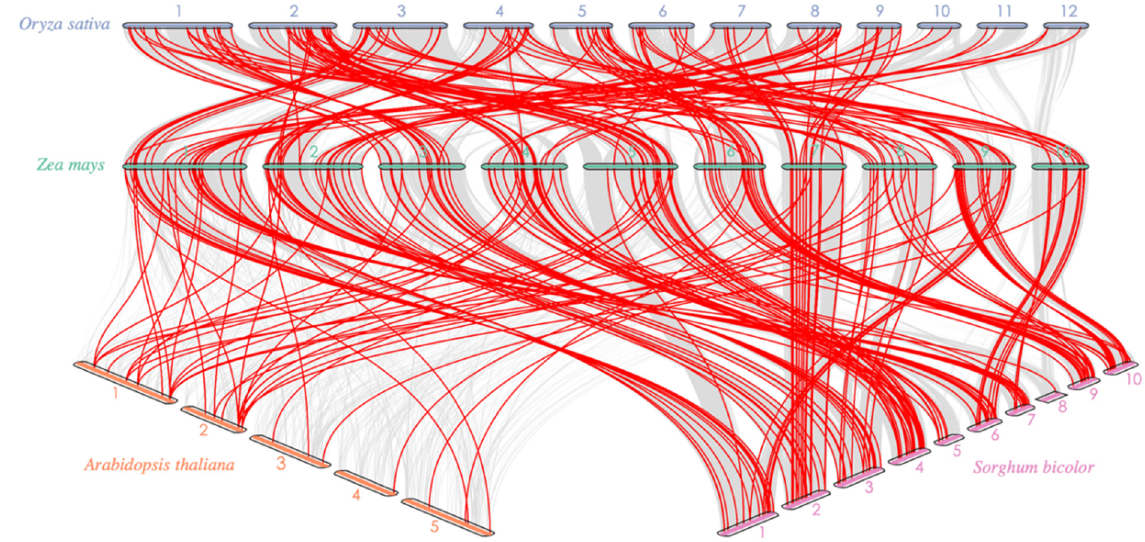
Figure 4. Synteny analysis of AP2 / ERFs between maize, Arabidopsis, rice, and sorghum.